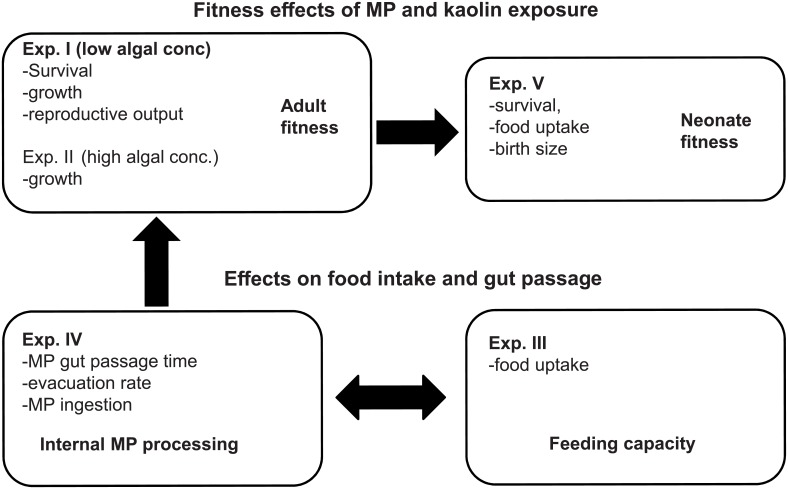
Study outline.Study outline showing the linkages between the experiments. In Experiments I-II and V, the effects of MP and kaolin exposure on fitness were studied in adults (Exp. I-II) and their offspring (Exp. V). In Experiments III-IV, food intake and MP behavior in the gut were examined and used to explain the MP effects on growth and reproduction observed in Experiments I-II and V.